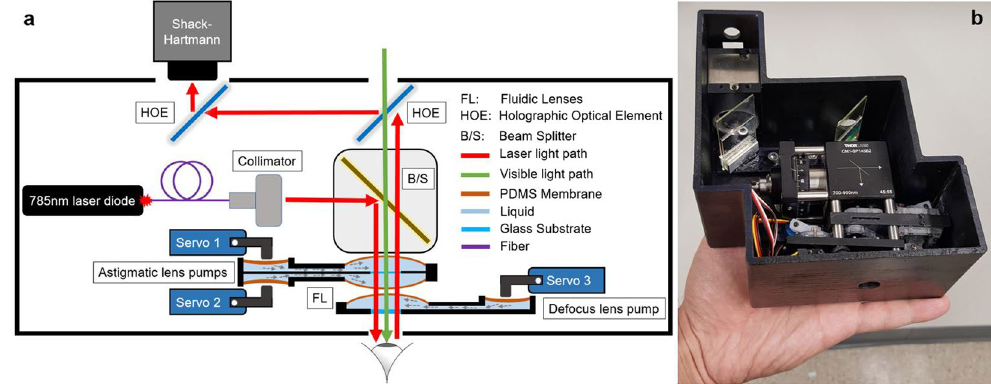
Figure 1. The auto-phoropter setup. (a) The red arrow in the schematic diagram shows the optical path of the 785 nm laser light that is used to detect the wavefront aberrations reflecting from retina. Green arrow depicts the patient’s line of sight. The tunable liquid lenses are controlled by servo motor actuated diaphragm pumps to correct the vision errors. (b) Fabricated auto-phoropter setup in black